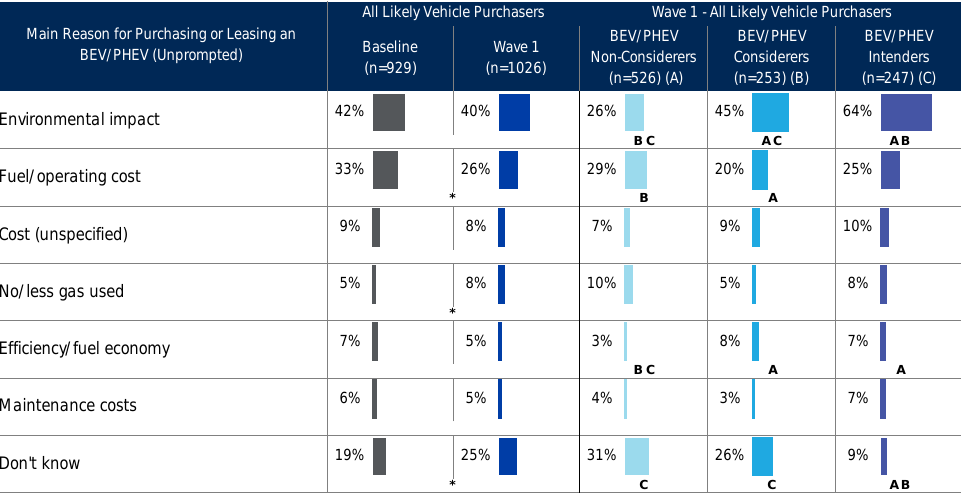
Figure 3. Unprompted reasons mentioned for purchasing or leasing a BEV or PHEV, by survey wave and segment (multiple responses allowed). Note: Letters A–C indicate statistically significant differences between likely vehicle purchaser segments (z-test for proportions, p < 0.05). * Indicates a statistically significant difference between Baseline and Wave 1 survey all likely vehicle purchasers (z-test for proportions, p < 0.05).